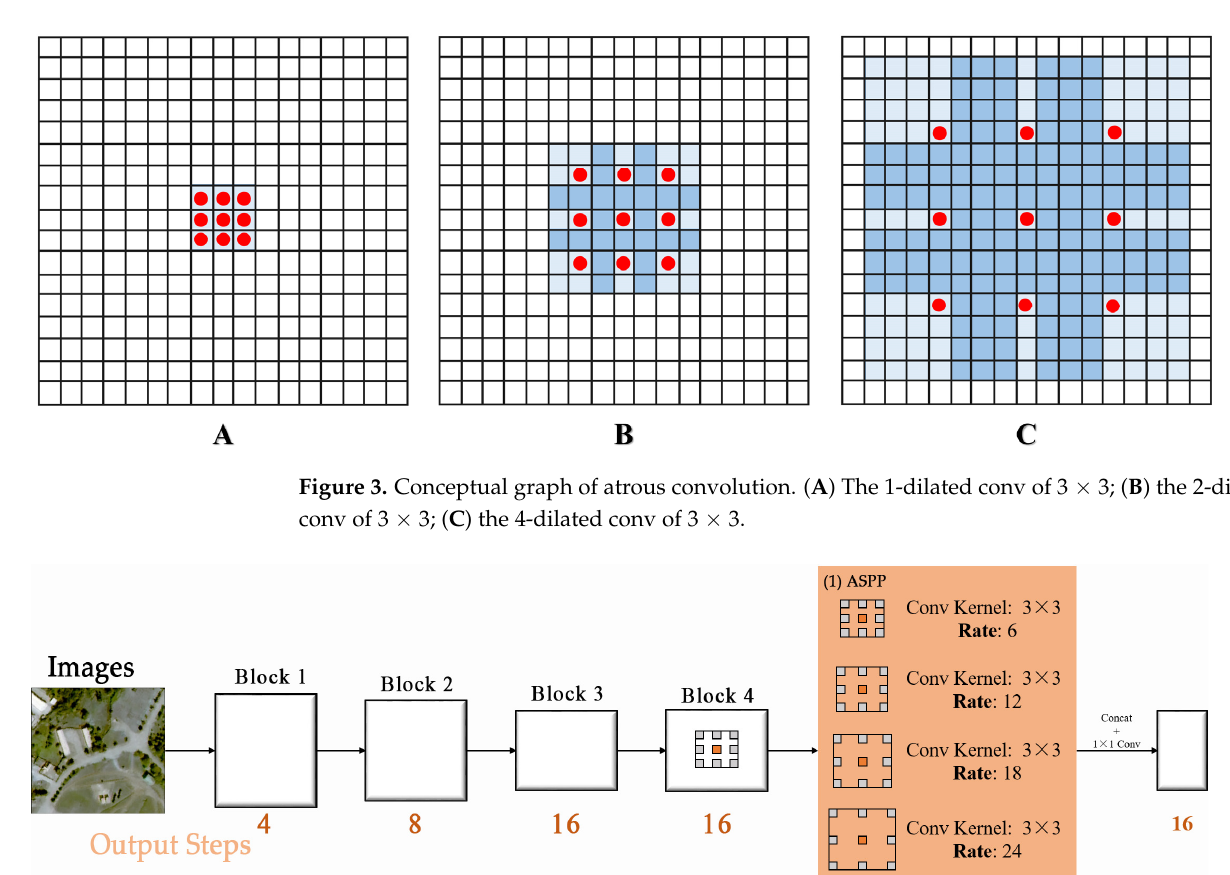
Figure 4. The structure of ASPP.